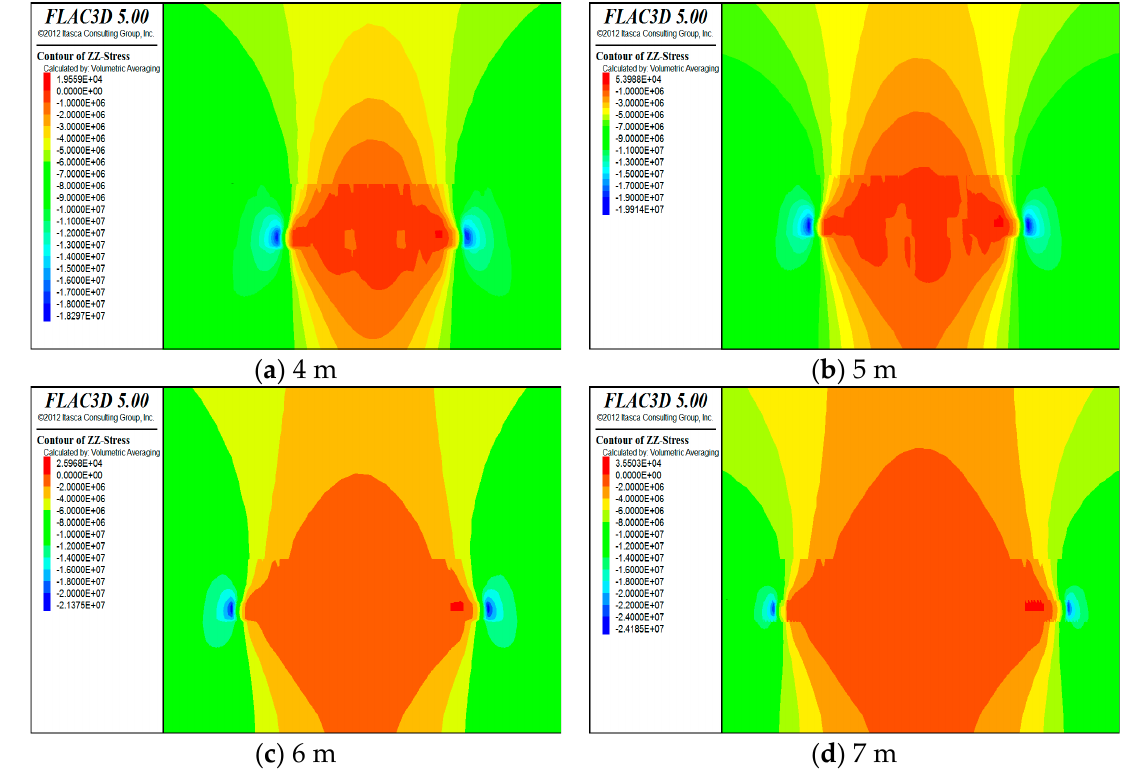
Figure 15. Cloud of vertical stress distribution for ( a ) 4 m, ( b ) 5 m, ( c ) 6 m, and ( d ) 7 m.